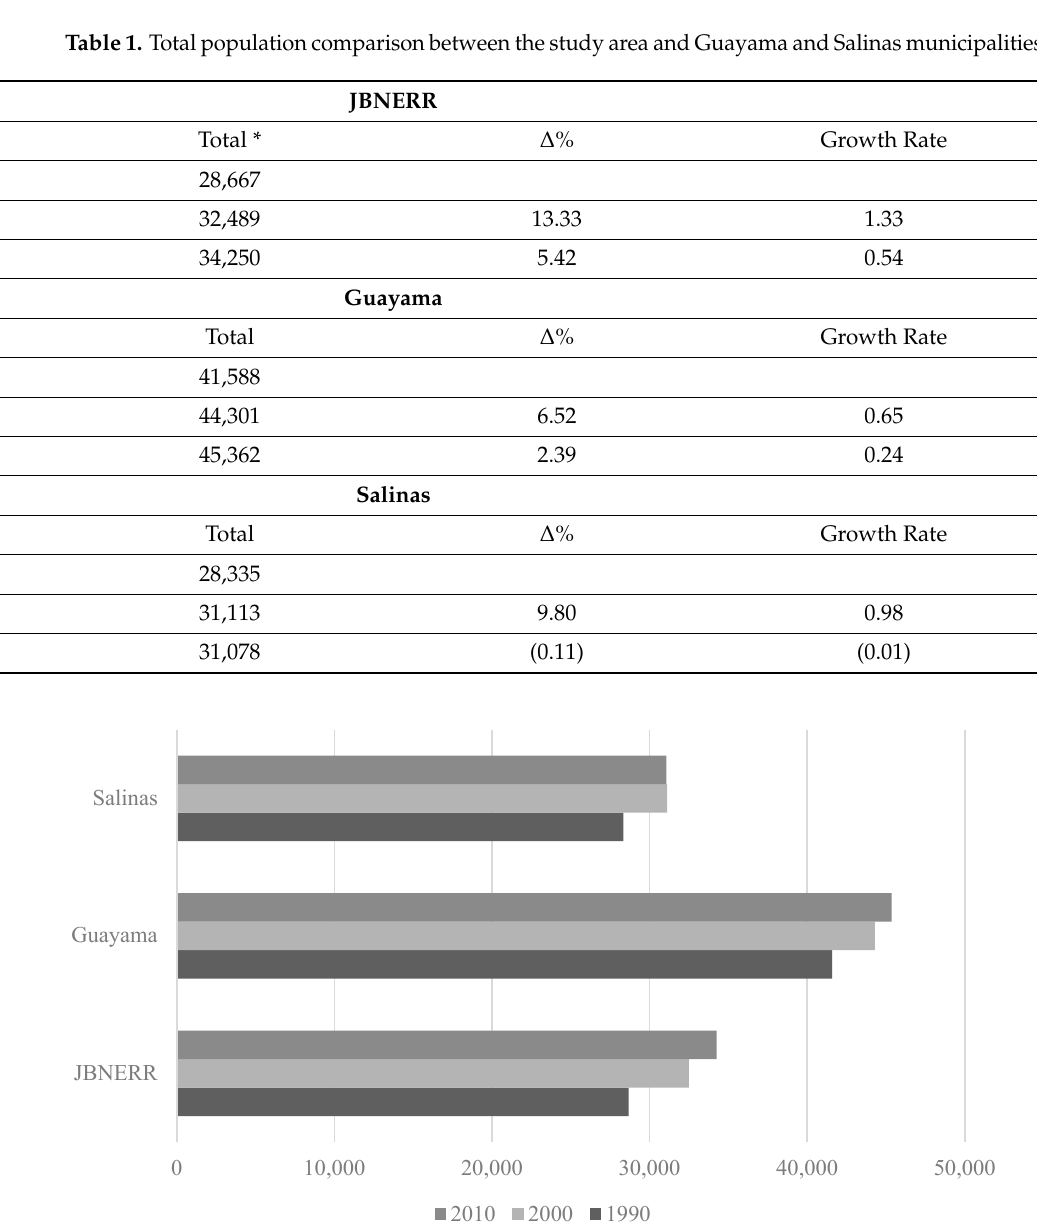
Figure 4. The population count in the study area and Guayama and Salinas municipalities.